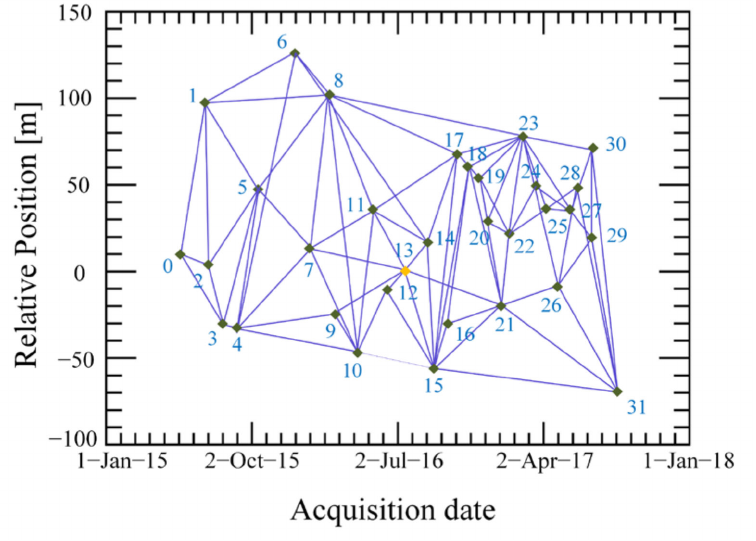
Figure 10. Spatio-temporal